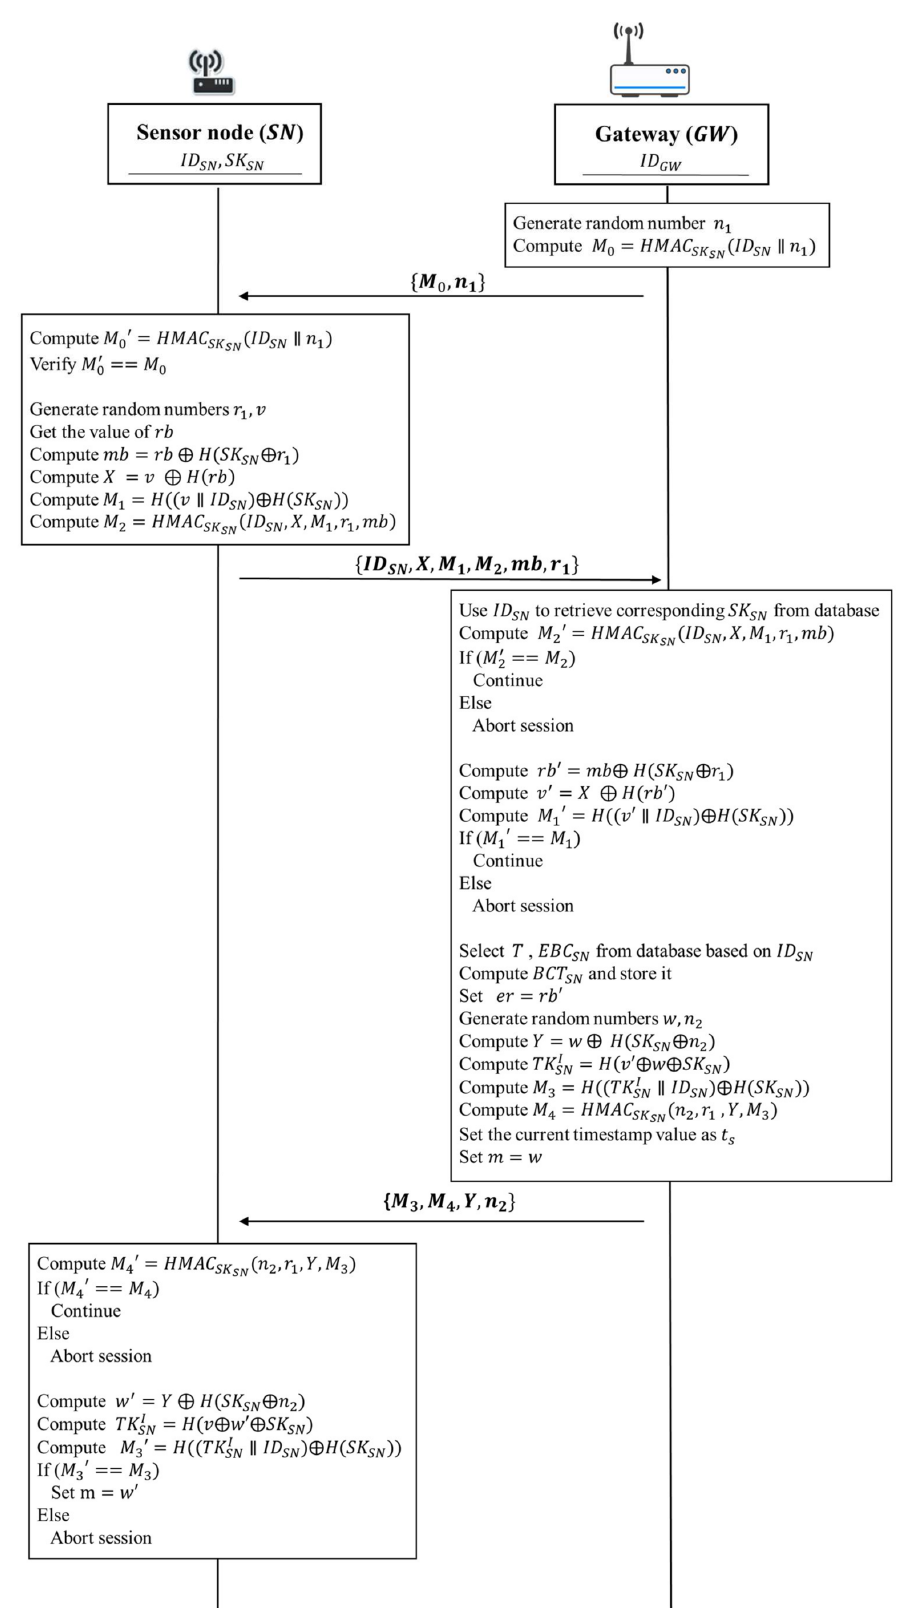
Figure 12. The static authentication phase for gateway initializing